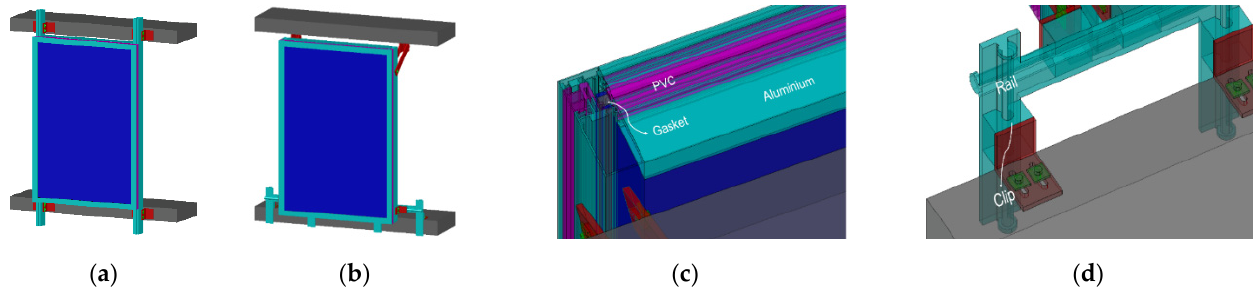
Figure 16. Details of the single-frame FE model in solid form: ( a ) FE model of conventional curtain wall; ( b ) FE model of seismic curtain wall; ( c ) internal member detail; ( d ) mobile fastener.